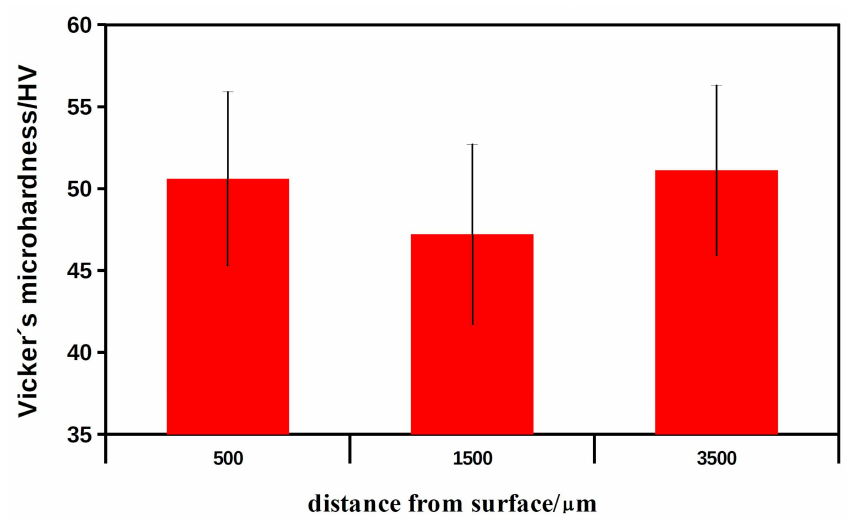
Figure 2. The values of Vicker microhardness of the new formed bone in the mandible at different distances from the bone surface with implanted HAP ceramic plates after 6 months of healing.